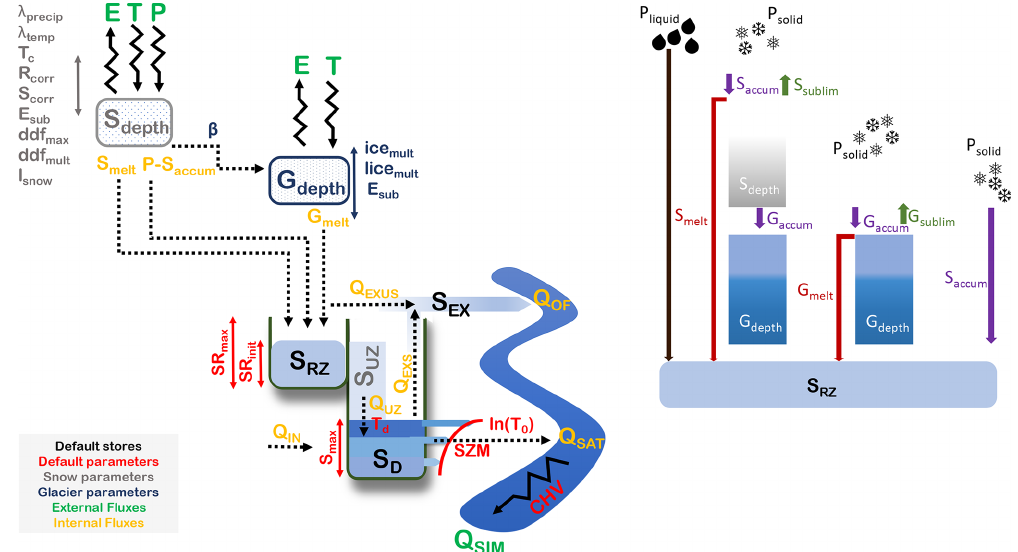
Figure 3. Conceptual diagram of the model adapted from Coxon et al. (2019) to show snow and glacier stores and model parameters (left). Glacier ice is situated beneath the snowpack or can be exposed if no snowpack exits (right). The snowpack accumulates when precipitation falls in solid form. Liquid precipitation, snowmelt and glacier melt are transported to the root